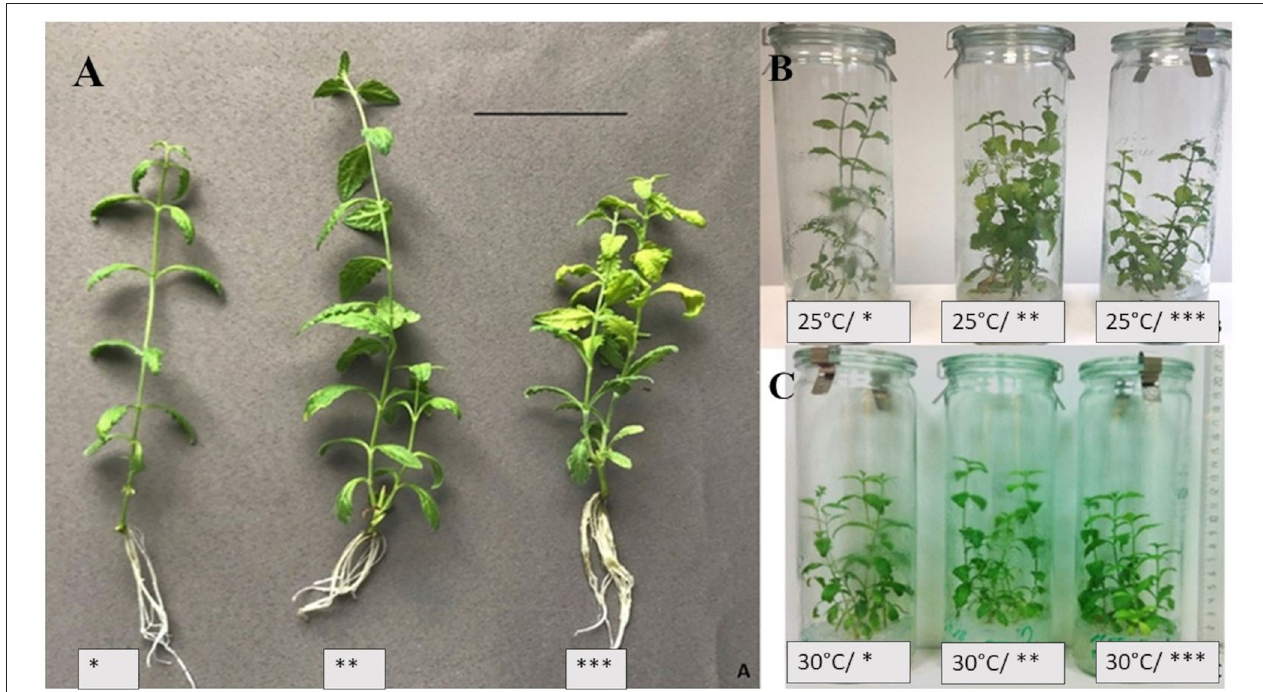
FIGURE 1 | S. yangii in vitro shoots cultured under three cool fluorescent white light intensities at 25 ◦ C (A) ; and at two temperatures: 25 ◦ C (B) or 30 ◦ C (C) ; LI: *70 µ mol m − 2 s − 1 ; **130 µ mol m − 2 s − 1 ; ***220 µ mol m − 2 s − 1 ; scale bar: 5cm.